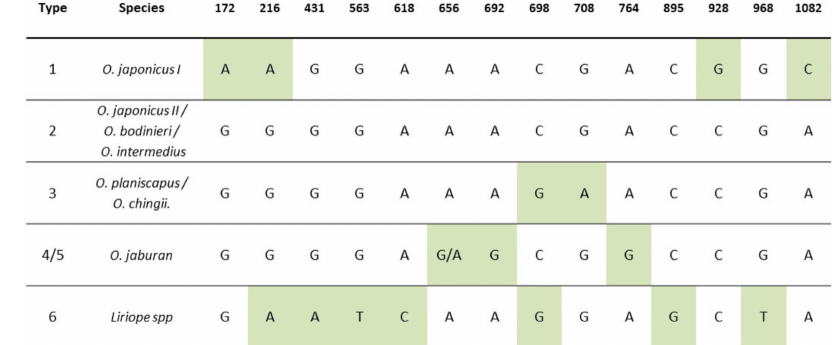
Figure 1. Diagram of the rbcL gene showing the positions of primer pairs used to amplify the central and 3 (cid:48) end region of the rbcL barcode region. The genus-specific diagnostic single nucleotide polymorphisms (SNPs) reported by Masiero et al., (2017) [26] and Ito et al. (2015) [27] are shown in relation to the primer pairs.